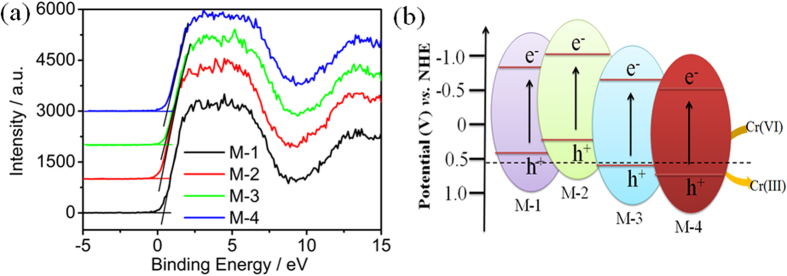
Proposed photocatalytic mechanism for MoSe2 under visible light irradiation.